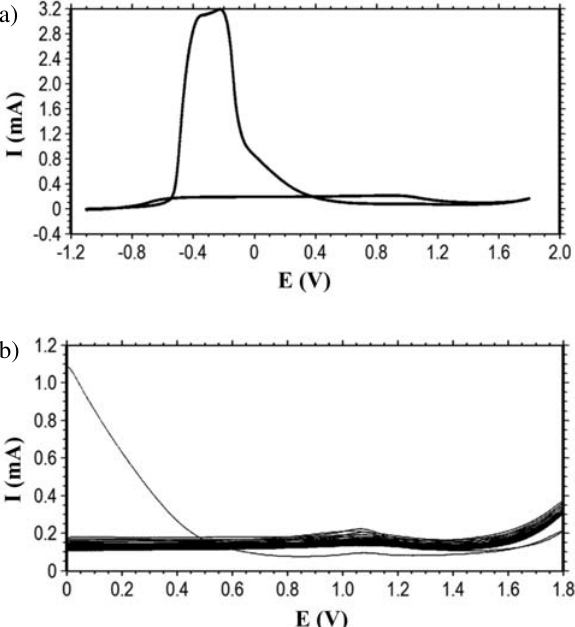
Fig. 1. First CV (a) and film growth curves (b) recorded for CS/Zn- Ni electrode 0.10 M N-methylpyrrole containing 0.20 M NaOX